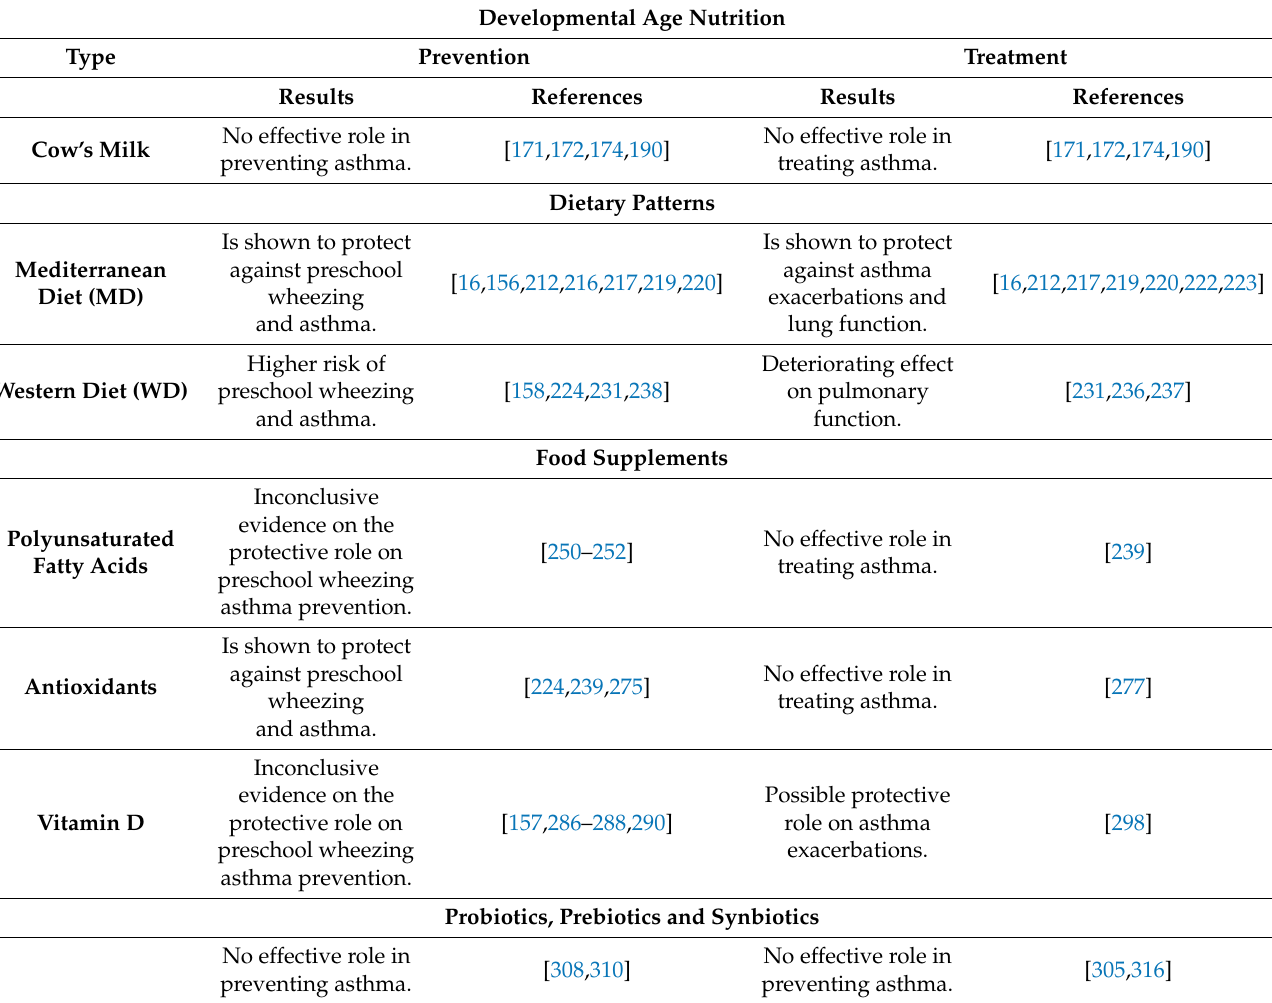
Table 3. Developmental-age nutrition effects on the prevention and treatment of asthma